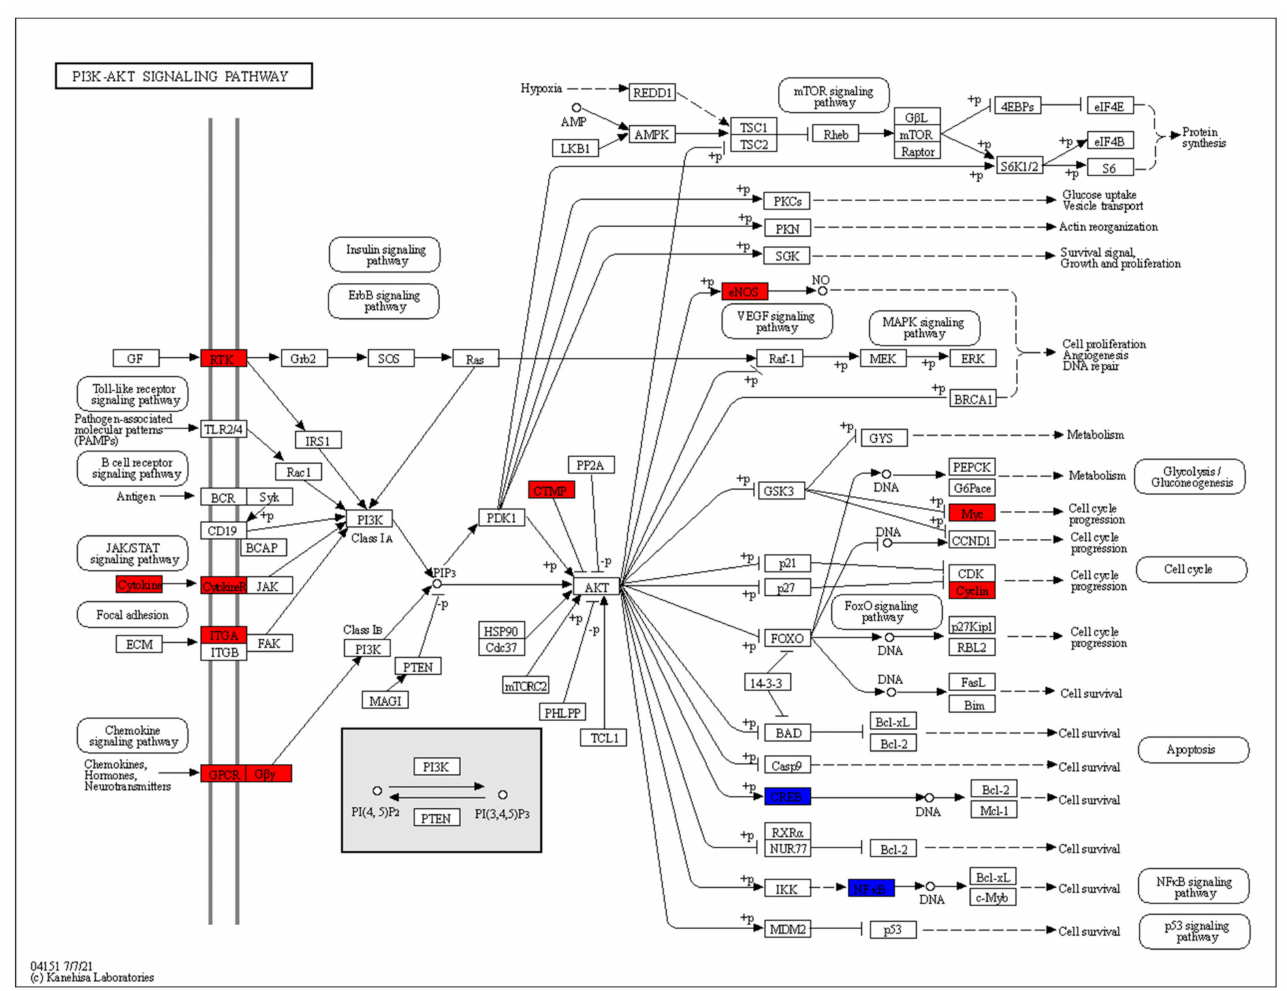
Figure 14. The differentially expressed genes of RA CD8 + Temra cells in the PI3K-AKT pathway. Red indicates upregulated genes and blue indicates downregulated